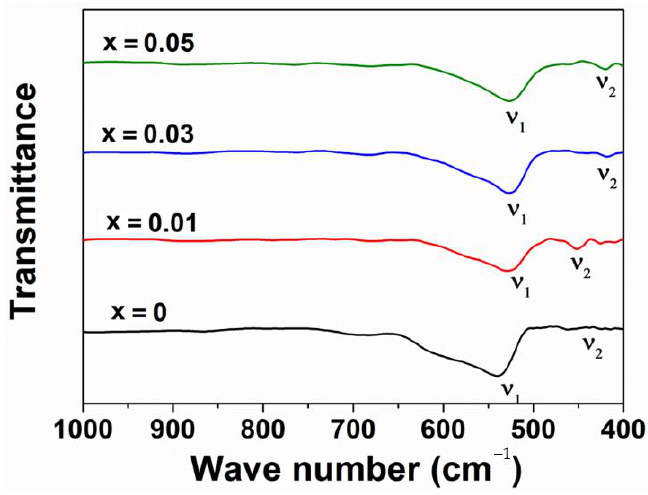
Figure 2. FT−IR spectrum of ZnNd x Fe 2−x O 4 nanoparticles. Figure 2. FT − IR spectrum of ZnNd